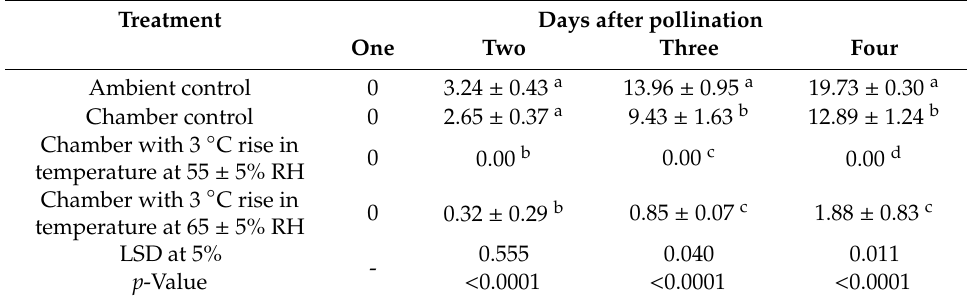
Figure 5. Longitudinal sections showing pollen tube growth in the pistil of the coconut variety WCT. ( a ) Pollen tubes growing inside the tubular canals three days after pollination and ( b ) pollen tubes accessing the micropylar region of ovule four days after pollination. Pollen tubes are marked by an arrow; pt, pollen tube; tc, tubular canal; ov, ovule; mc, micropyle. Sections of the pistil were stained with quadruple stains [59] and visualized using a stereo microscope. Scale bar = 100 μ m. Table 2. In planta mean pollen tube growth (mm) ± SD ( n = 6) through pistil of the coconut variety WCT under ambient, chamber control and chamber control with a rise in temperature of 3 ◦ C with 55 ± 5% RH and 65 ± 5% RH. The flowers were artificially pollinated as and when they became receptive and pollinated flower samples were taken daily for documenting pollen tube growth under all the treatments.